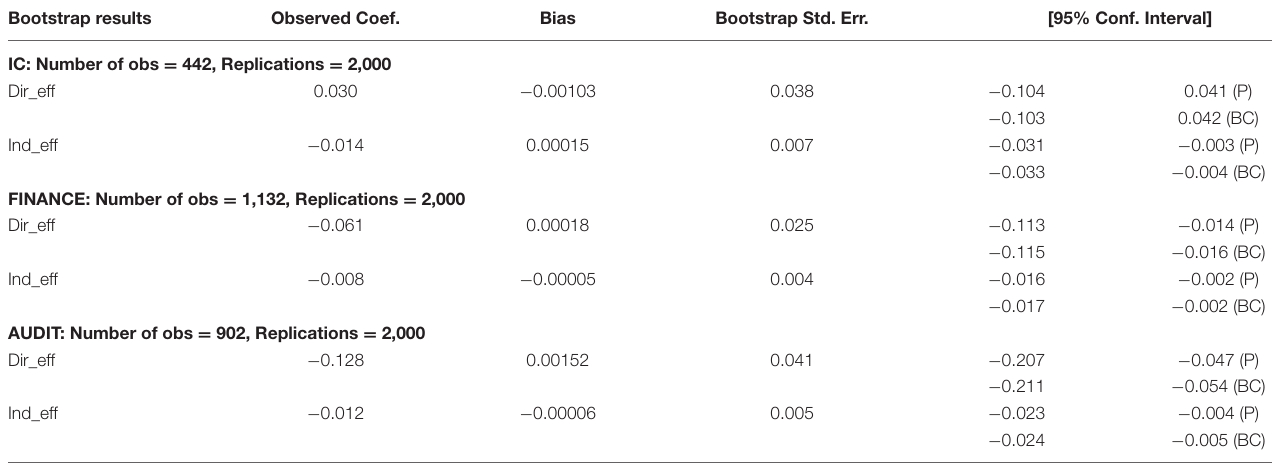
TABLE 12 | Robustness test: mediation effect. Bootstrap results Observed Coef.